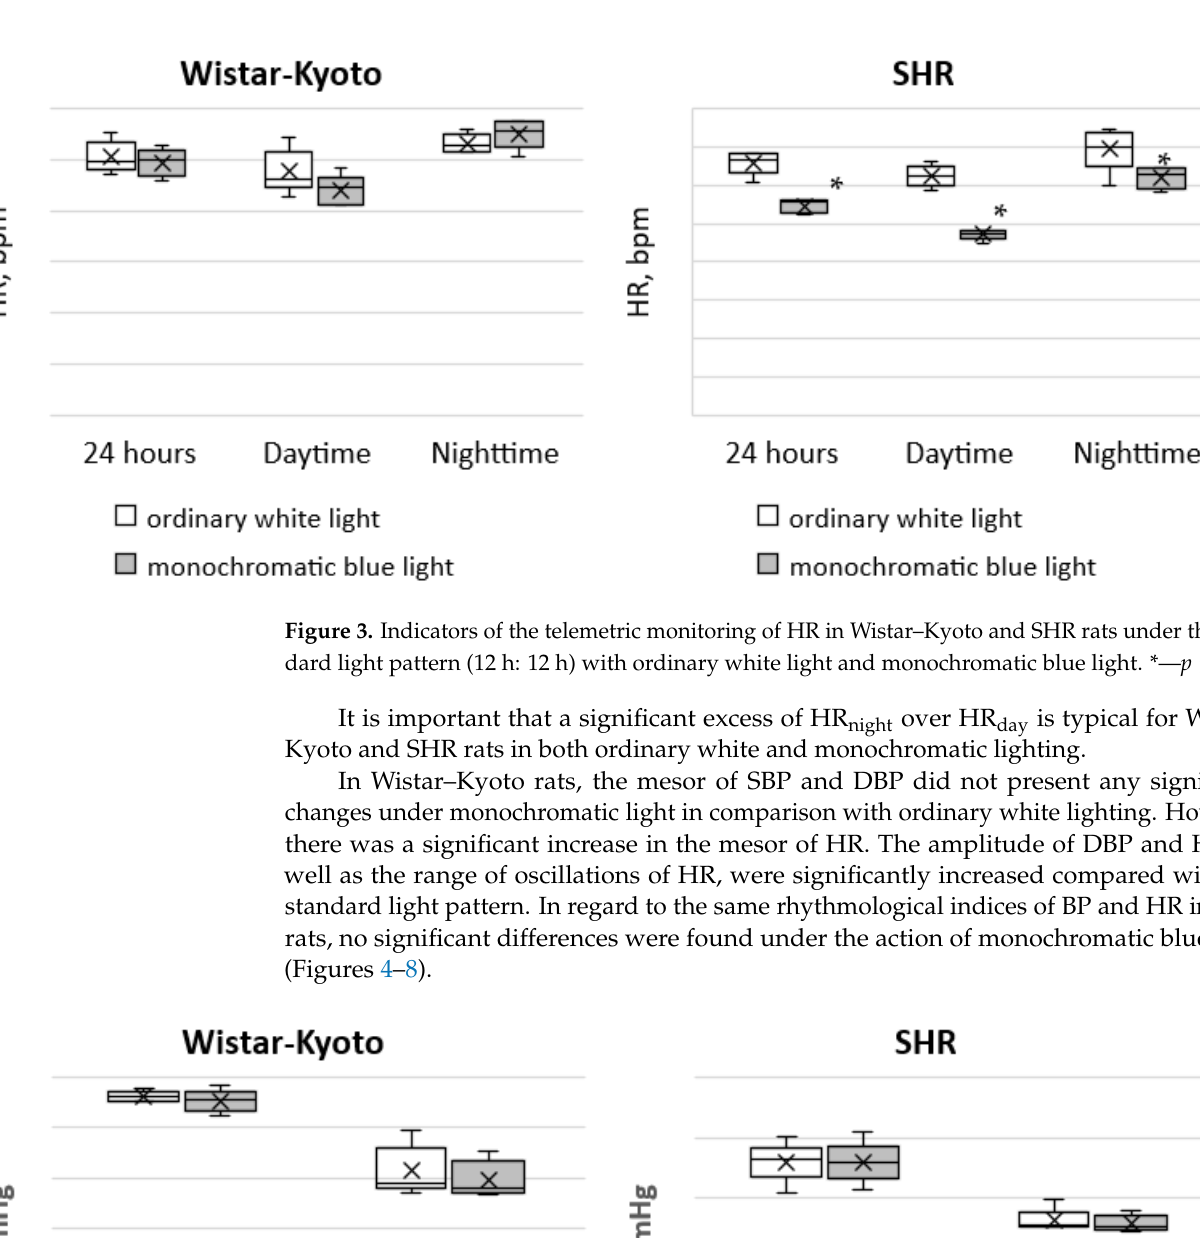
Figure 4. Mesor of SBP and DBP in Wistar–Kyoto and SHR rats under the standard light pattern (12 h:12 h) with ordinary white light and monochromatic blue light.